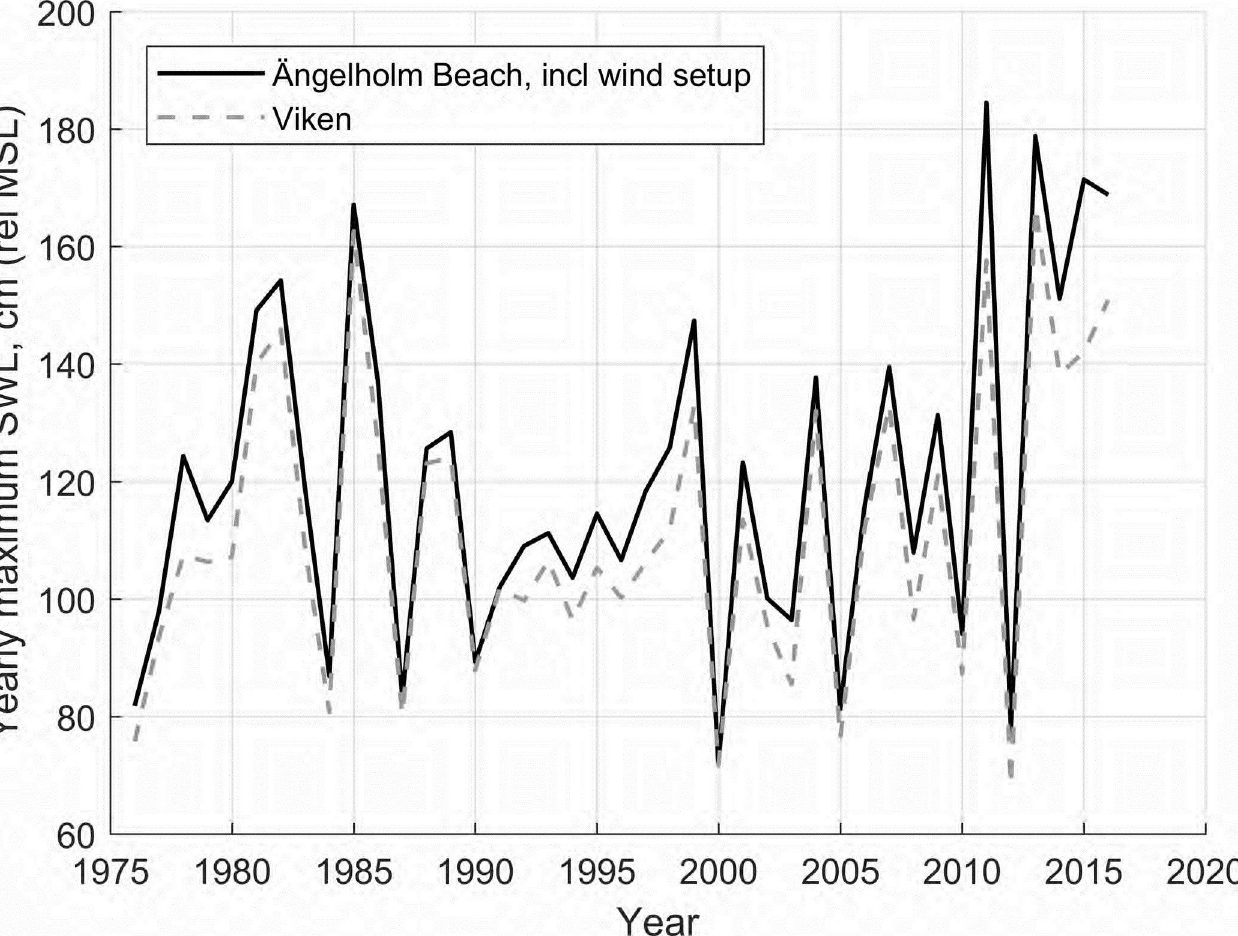
Fig 9. Yearly maximum SWL in 1976–2016 based on measurements from Viken (dashed grey line) and the yearly maximum corrected for local wind setup in Ska¨lderviken Bay (solid black line).